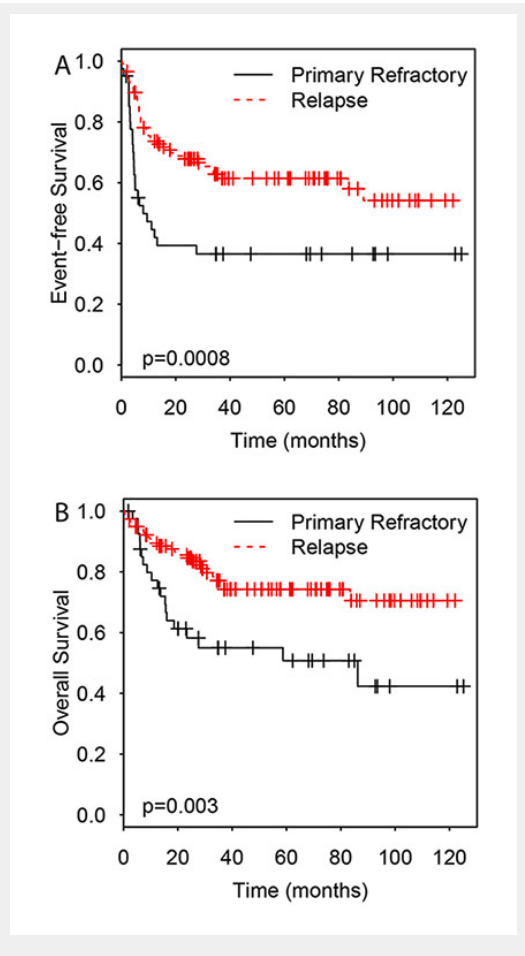
Impact of chemosensitivity to primary chemotherapy on event free survival (A) and overall survival